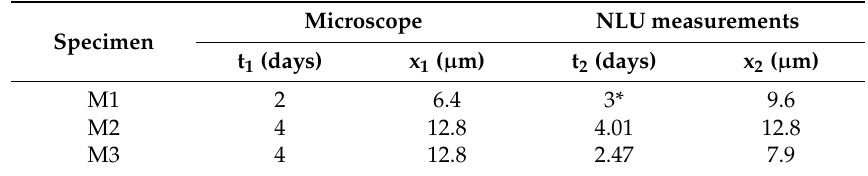
Table 4. The relevant parameters of the detection of the cracking of the tested specimens.